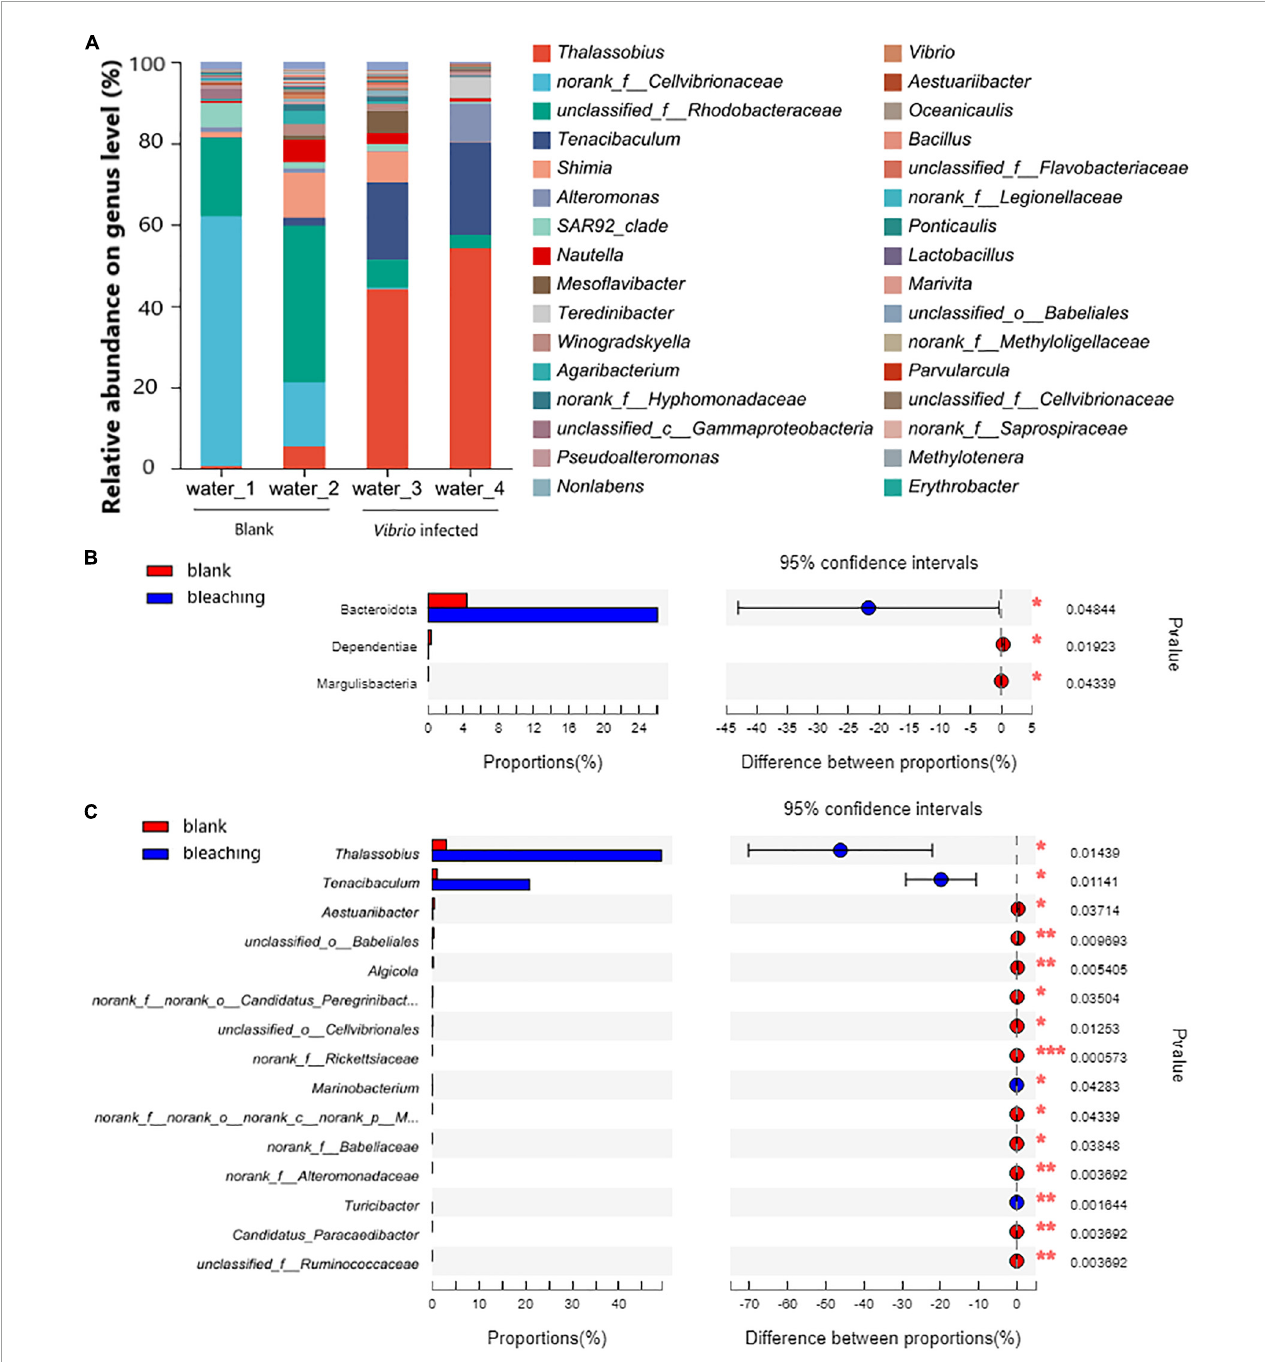
FIGURE7 Community composition of planktonic bacteria in water on genus level. The total genomic DNA of planktonic bacteria in water from each group performed high-throughput sequencing on the 16S rRNA. The taxonomy of each OTU representative sequence was analyzed by RDP Classifier version 2.2 and classified on the genus level. The OTUs were analyzed by student’s t -test to compare the difference in abundance between groups: (A) is the microbial structure presented by relative community abundance; (B) is the phyla with a significant difference in abundance; and (C) is the top 15 genera with a significant difference in abundance which were listed from higher abundance to low. Results of statistical analysis are presented by the significant difference indicated by * where 0.01 ≤ P ≤ 0.05, ** where 0.001 ≤ P ≤ 0.01, and *** where P ≤